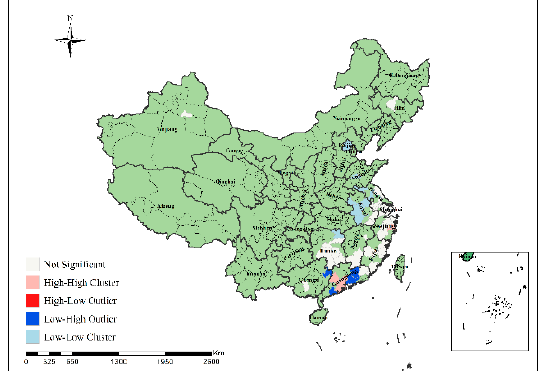
Figure 8. Local spatial autocorrelation analysis results of H7N9 outbreaks in China in 2014.